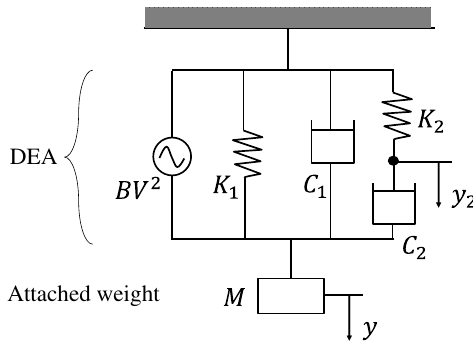
Figure 6. Mechanical impedance model of a suspended